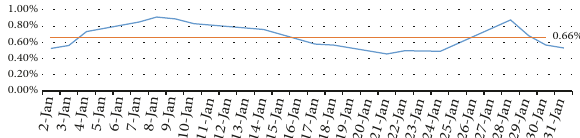
Figure 9: The everyday offline ratio in January 2018. The mean offline ratio is 0.66% which is very